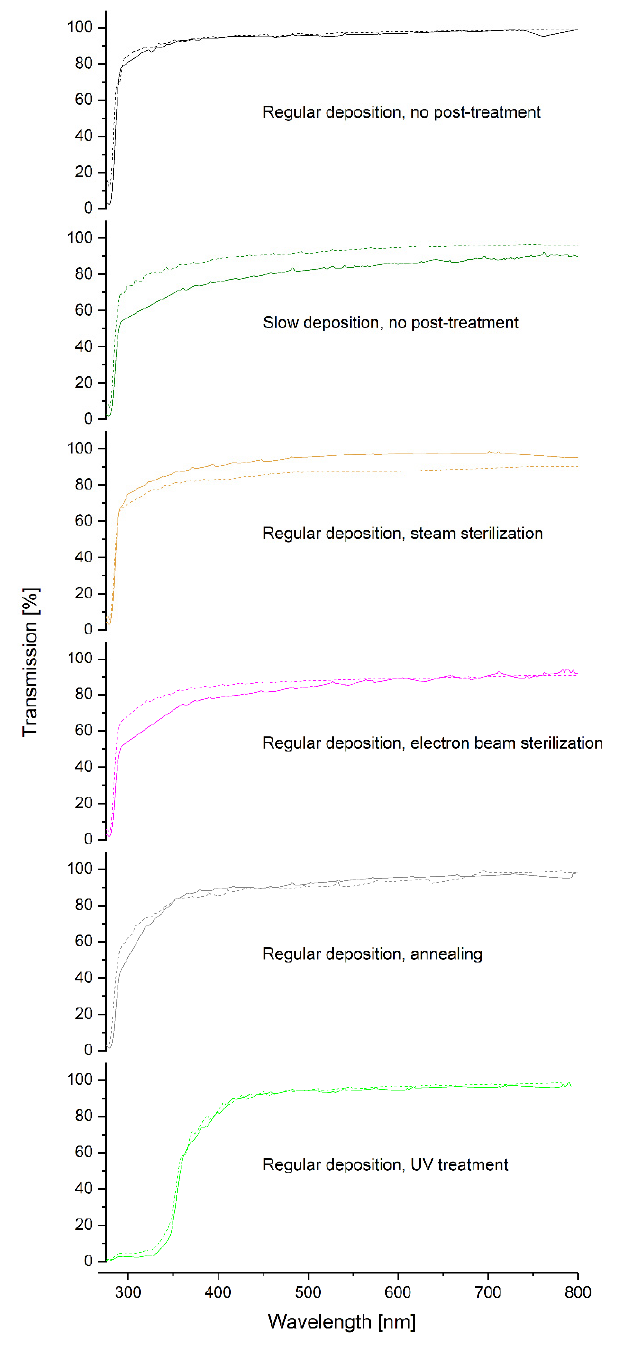
Figure 7. UV-VIS spectra for the different samples after correction of the sinusoidal overlap. The solid lines represent the spectra after fabrication, whereas the dashed lines represent the spectra after a non-accelerated aging time of ~1800 days.